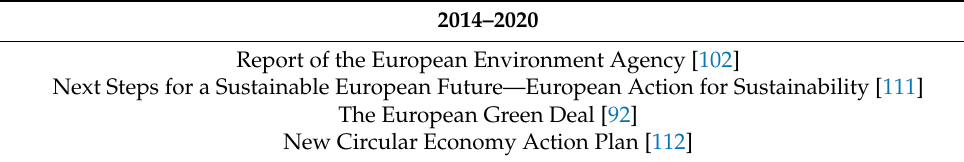
Table 10. Legislation of the European Union from 2014 to 2020.